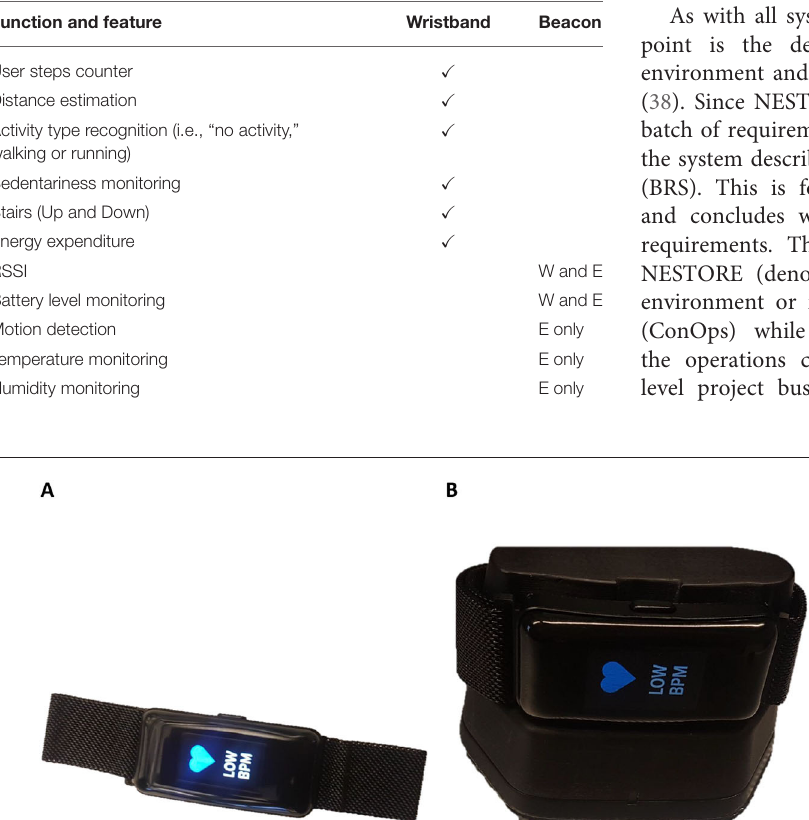
Frontiers in Digital Health |